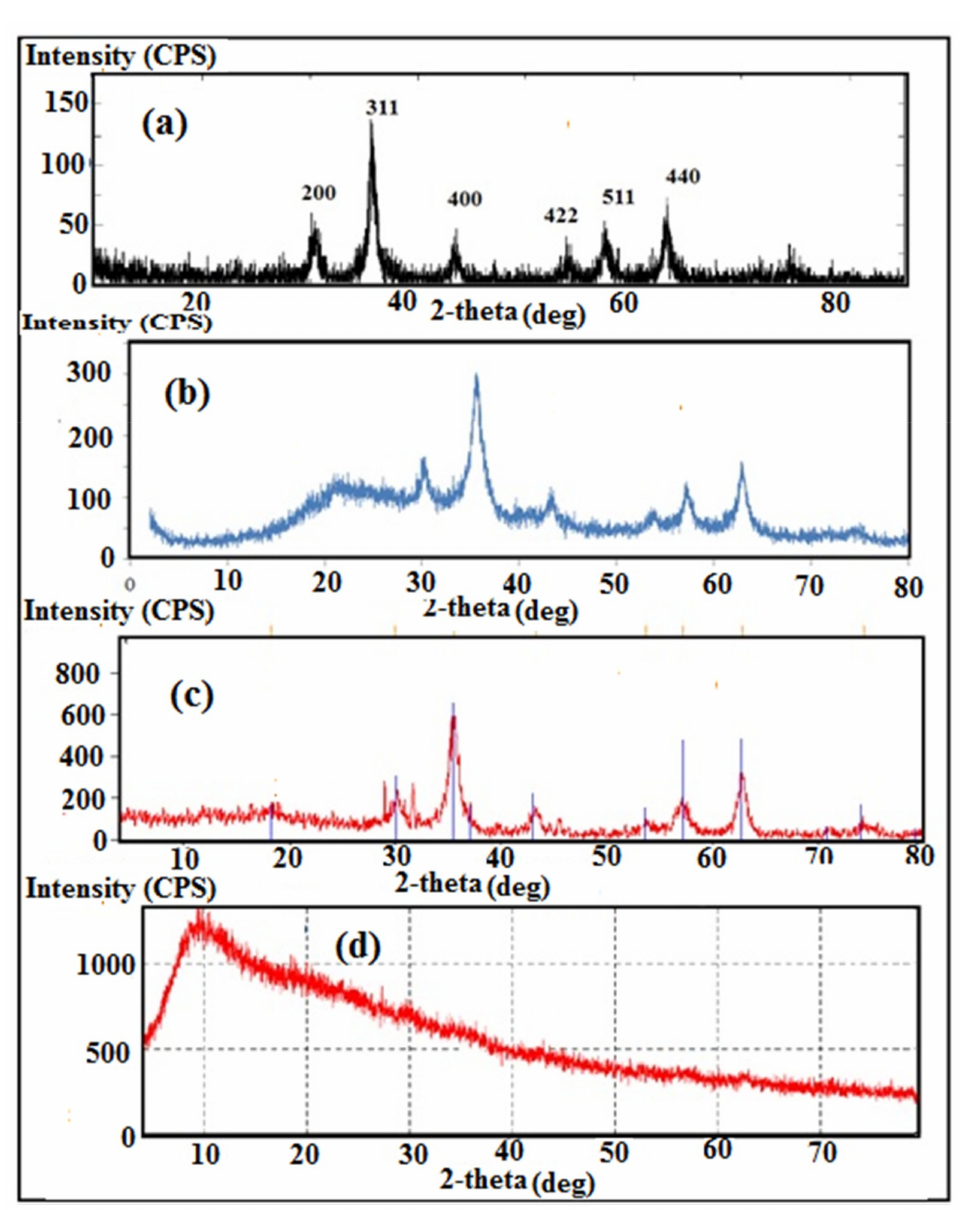
Figure 3. XRD di ff ractograms of ( a ) Fe 3 O 4 NPs; ( b ) Fe 3 O 4 -QVP / AAm; ( c ) QVP / AAm-Fe 3 O 4 ; ( d ) QVP /